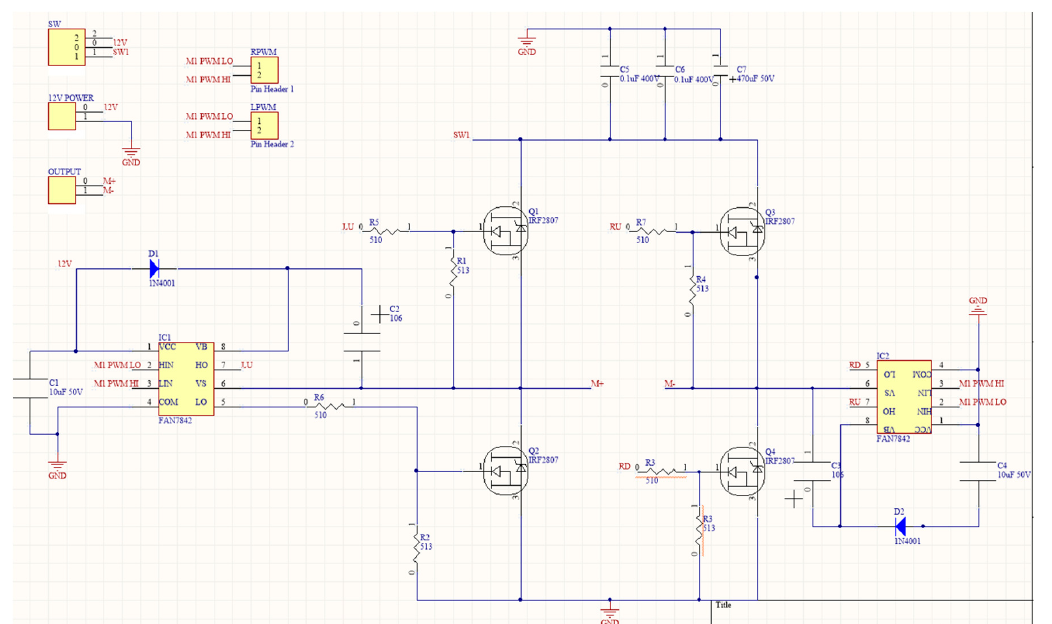
Figure 4. Motor drive circuit diagram.